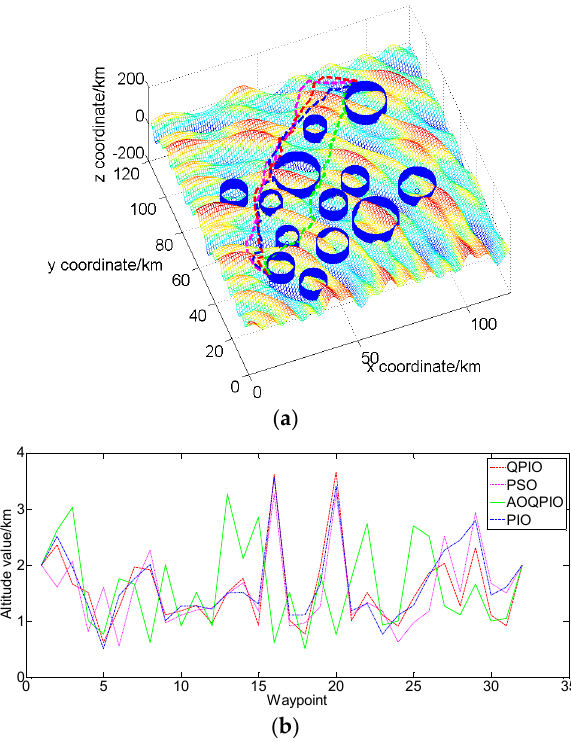
Figure 4. ( a ) is the result of all algorithms and ( b ) is the result of optimal UAV altitude of the experiment carried out in map 2.